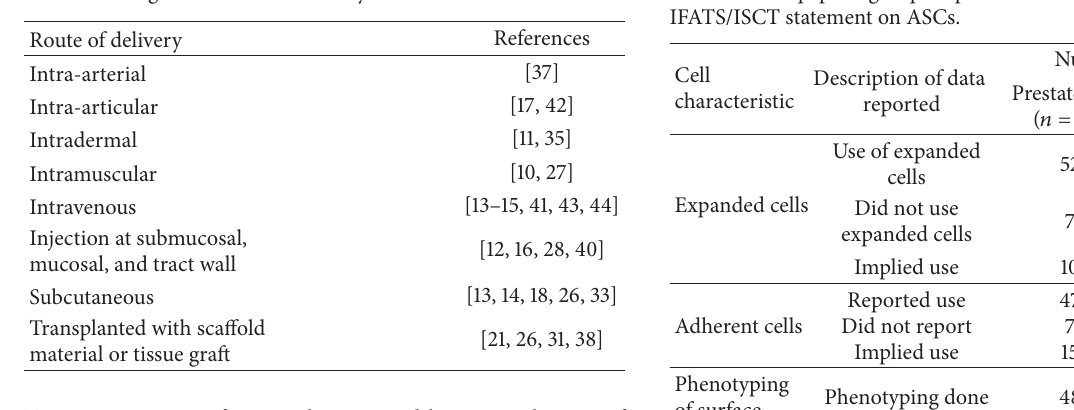
Table 2: Summary of papers that reported human application of ASC according to the route of delivery of stem cells.